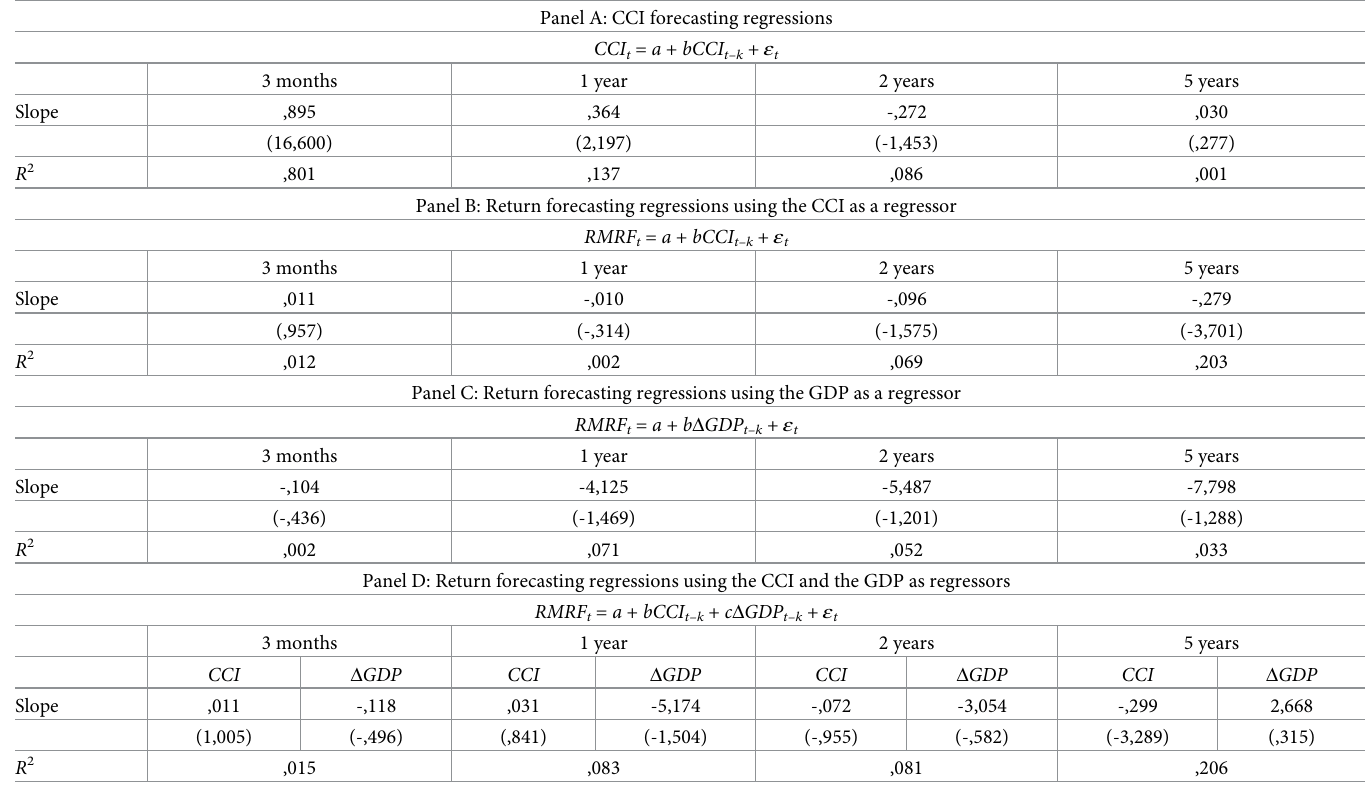
Panel A: CCI forecasting